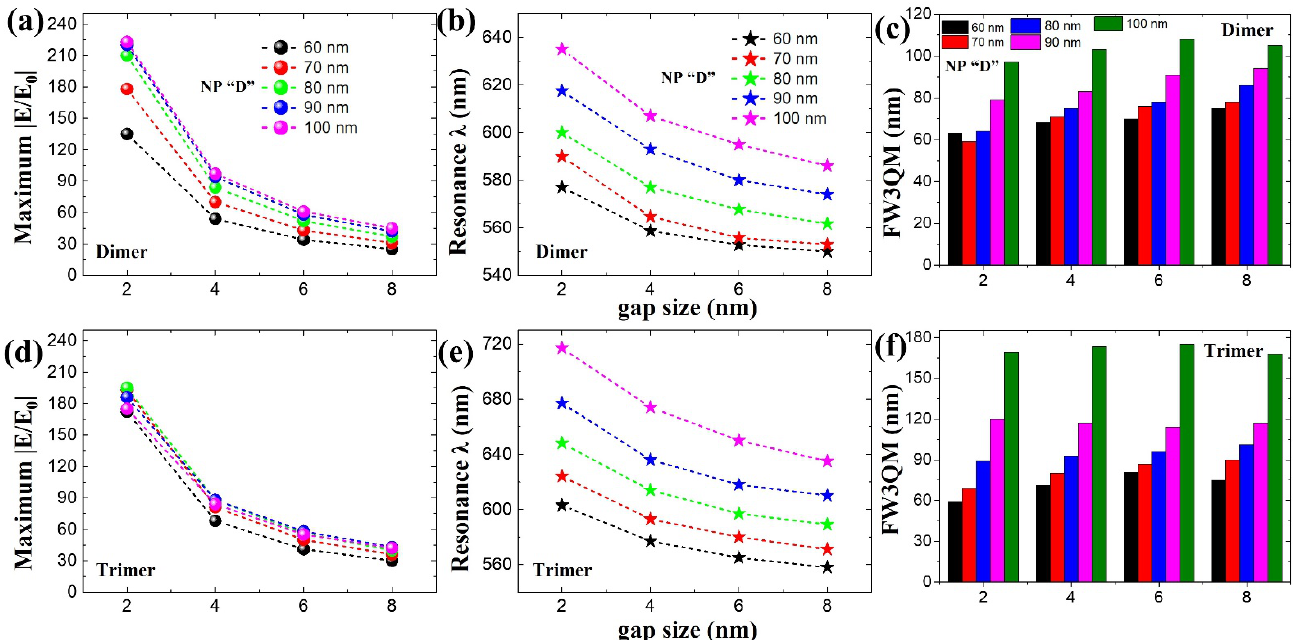
Figure 6. Size-dependent spherical NP’s plasmonic properties for ( a – c ) dimer and ( e , f ) trimer nanostructures. NP “D” is varied from 60 nm to 100 nm. Maximum near-field strength |E/E 0 | obtained from dimer ( a ) and trimer ( e ) plasmonic nanostructures from its respective resonance wavelength positions ( b ) and ( e ), respectively. FW3QM results of dimers ( c ) and trimers ( f ) for different gap sizes ranging from 2 nm to 8 nm as a function for different NP “D” sizes. These data are extracted from simulated broadband |E/E 0 | spectra from SM Figures S6 and S7.